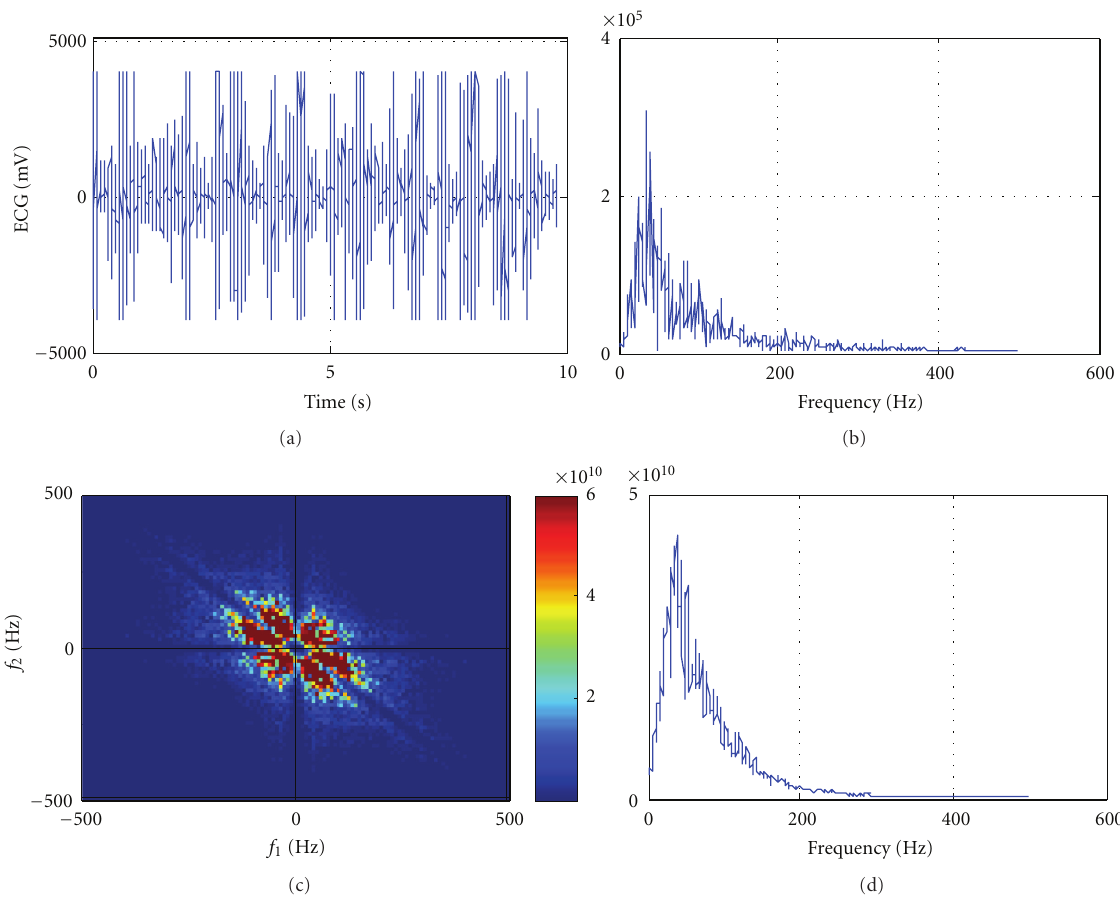
Figure 2: (a) The EMG activity of aggressive action, (b) its power spectrum, (c) its bispectrum, and (d) its bispectrum in 2 dimensions.